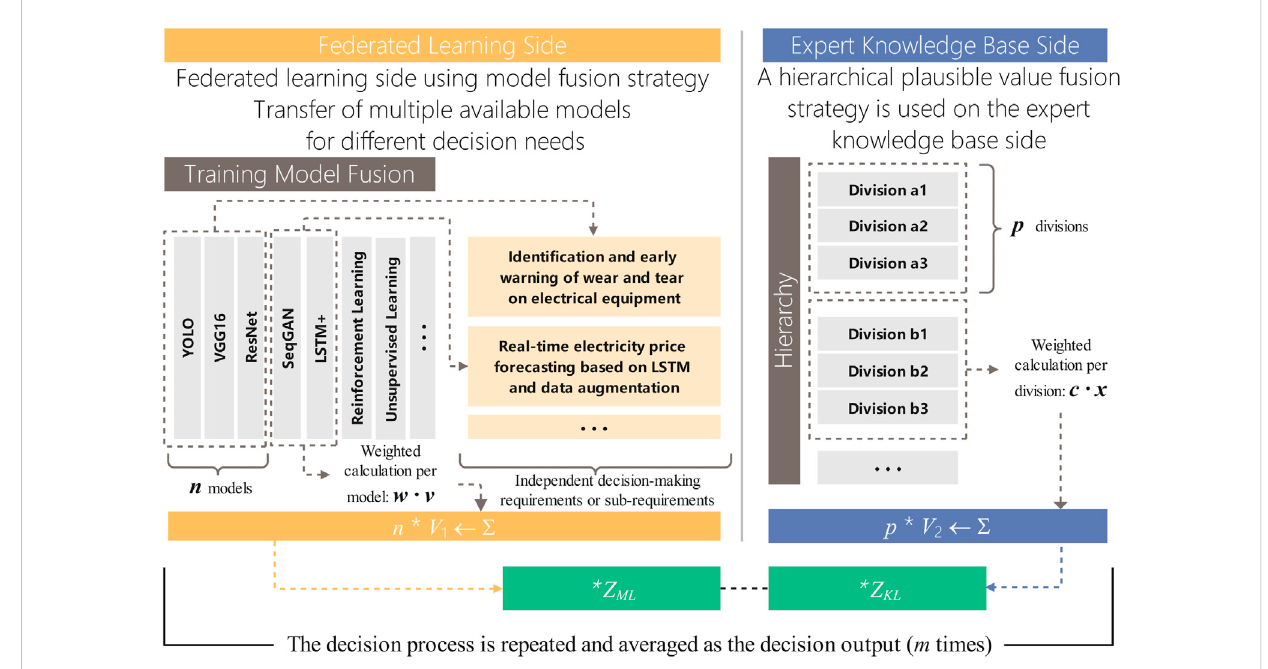
FIGURE 5 Decision con fi dence value fusion process.